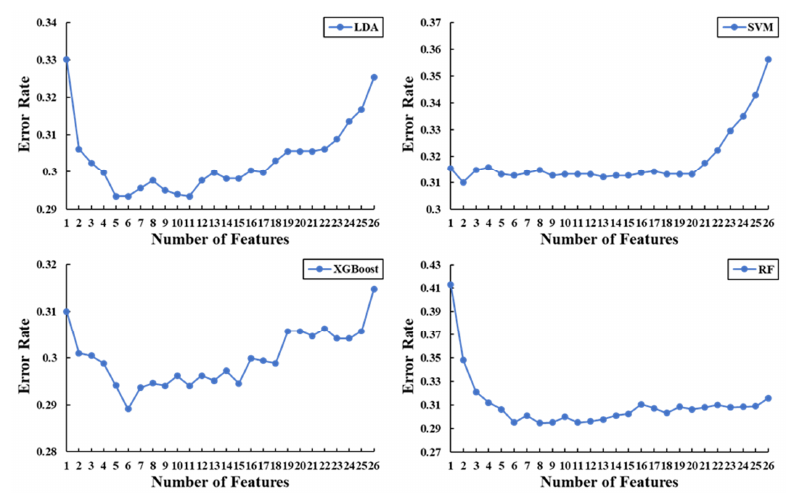
Figure 4. Results of the error rate of the four classifiers with different numbers of features.